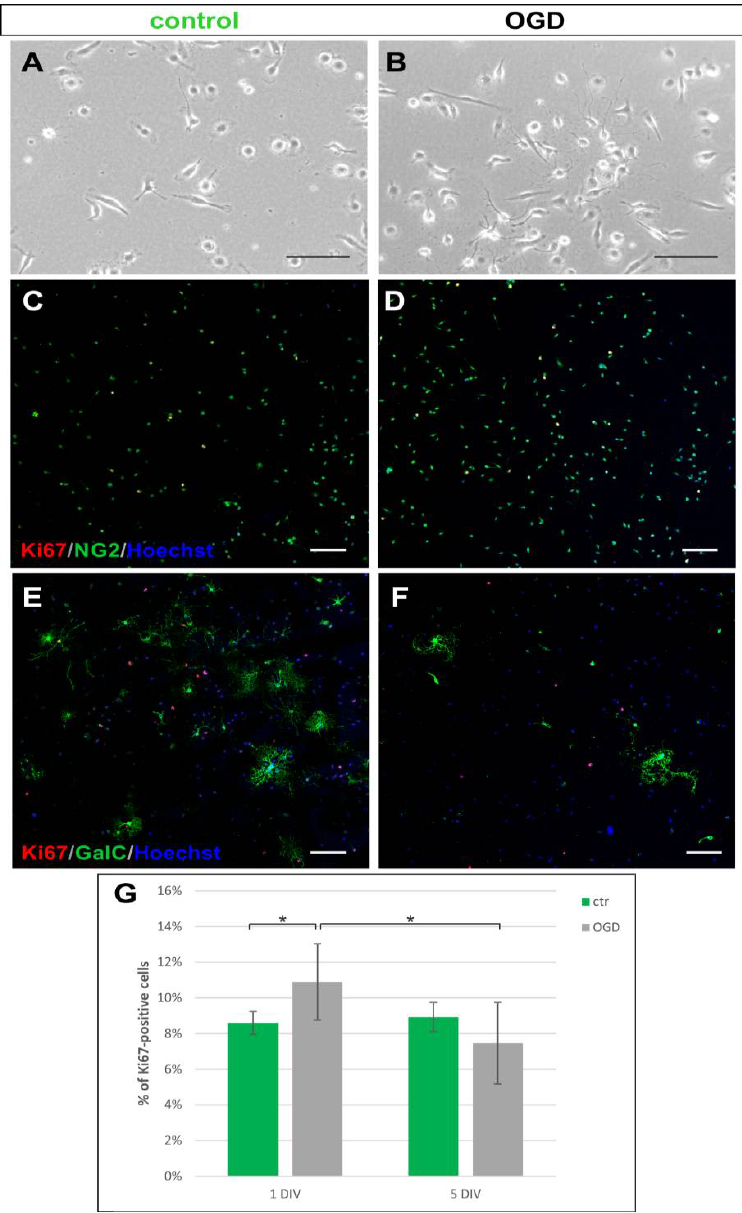
Figure 5. Proliferating and differentiating neonatal oligodendrocytes in vitro. Live imaging of oligodendrocytes cultured in the serum-free condition in physiological normoxia ( A ) and 24 h after OGD procedure ( B ). ( C , D ) Dividing, as indicated by immunostaining with anti-Ki67 antibody (red), NG2-positive oligodendrocyte progenitors (green), which are more numerous after the OGD procedure. ( E , F ) GalC-positive (green) differentiating, ramified cells in proliferating (Ki67 + ) oligodendrocyte population. Temporal limitation of oxygen and glucose exerts a negative effect on cell branching during the maturation process. Cell nuclei are visualized with Hoechst (blue). The scale bar corresponds to 50 μm. ( G ) Graphical presentation of the oligodendrocyte number in controls